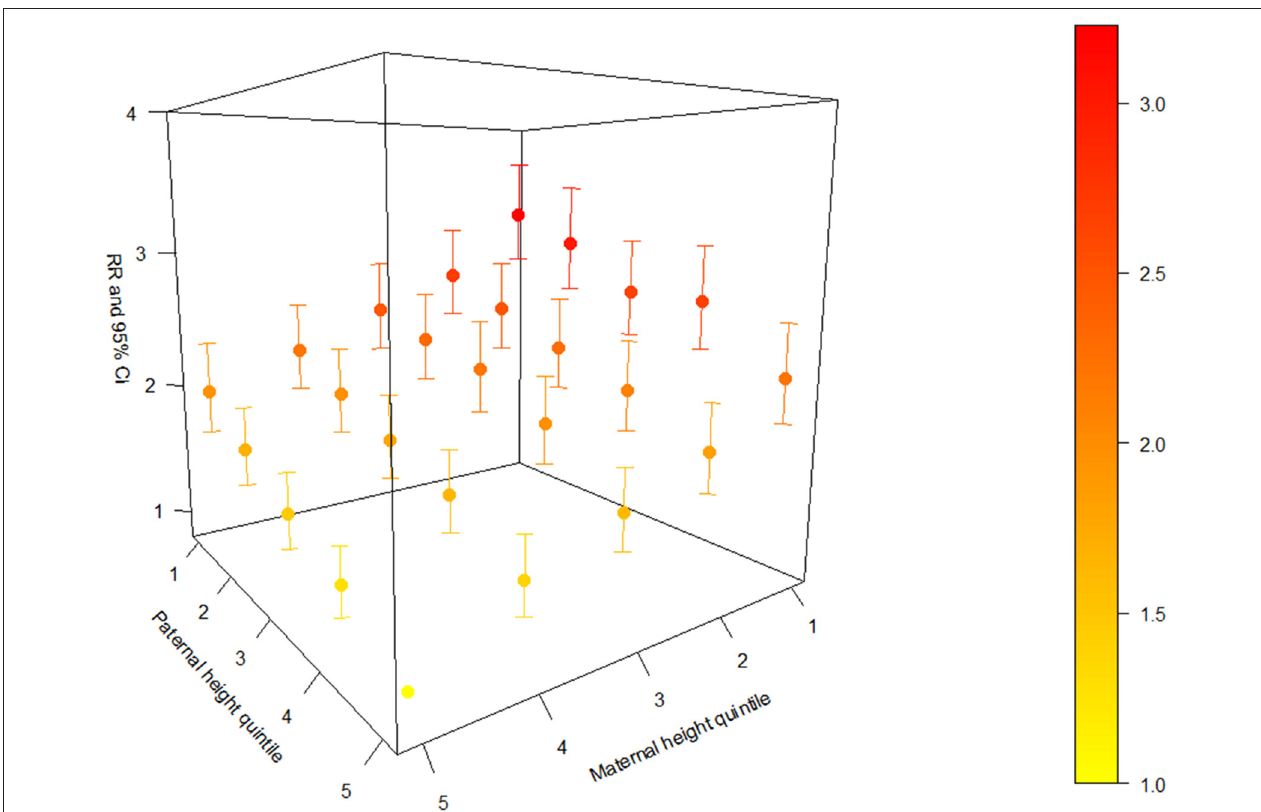
FIGURE 1 | Adjusted relative risk (RR) with a 95% confidence interval (CI) based on each combination of maternal and paternal height